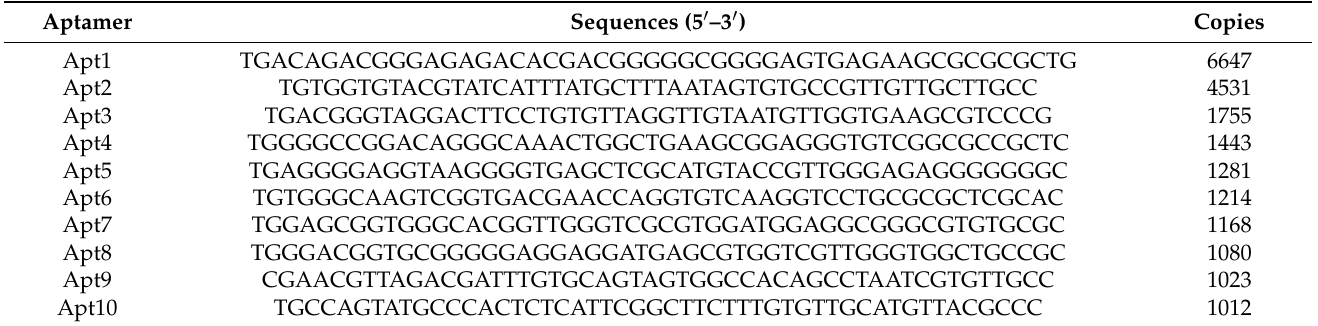
Table 2. Selected oligonucleotide sequence candidates. The ten most frequent oligonucleotide sequences obtained after next-generation sequencing (NGS) of the 8th cell-SELEX cycle. Only the sequence corresponding to the random region is shown (primer binding sites are nor